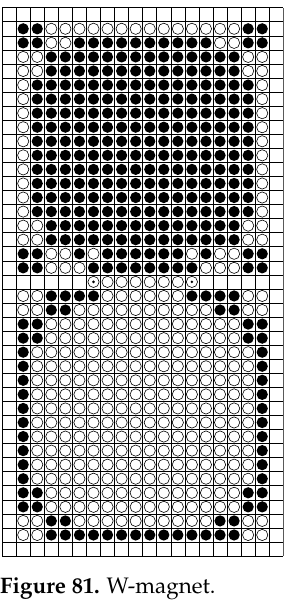
Figure 81. W-magnet.